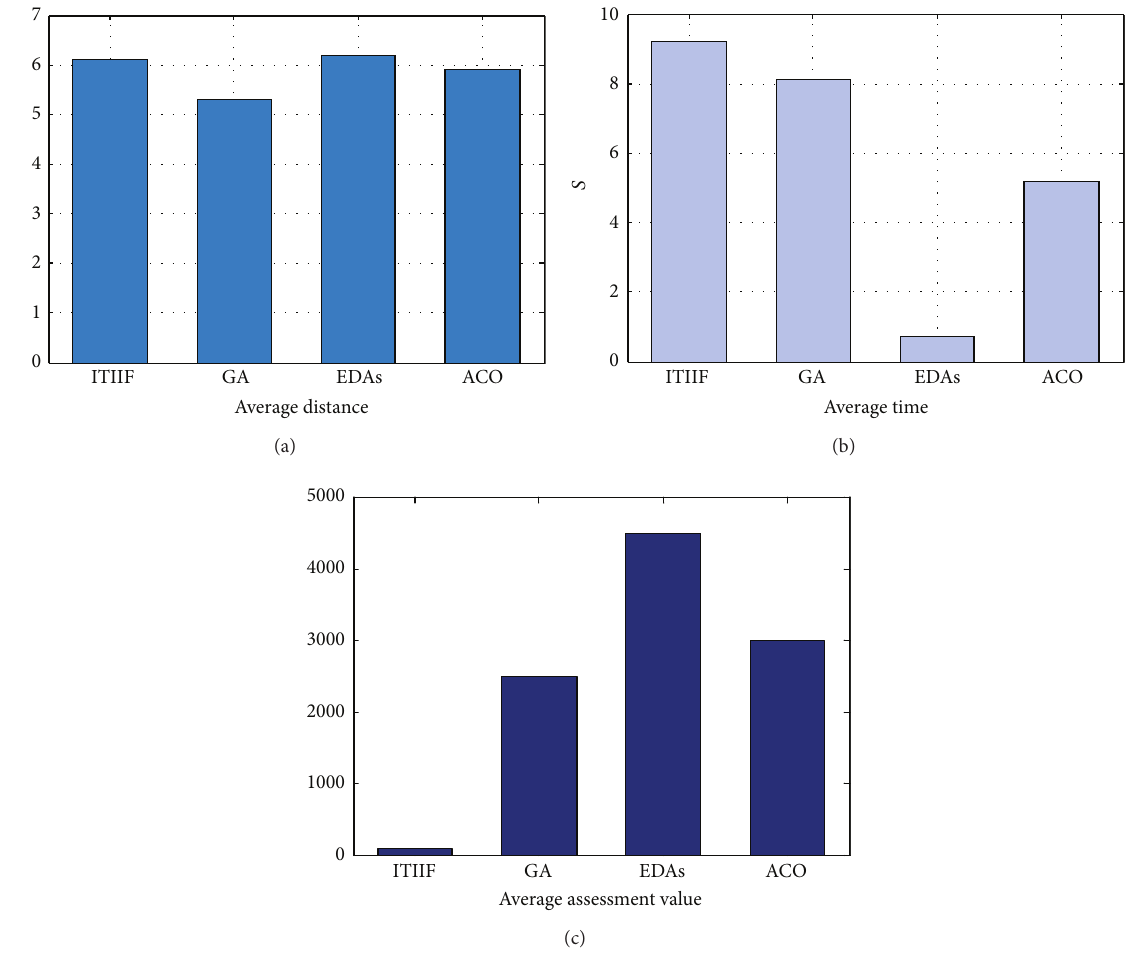
Figure 7: The performance comparison of ITIIF, GA, EDAs, and ACO. Table 2: The solution results of the testing functions by ITIIF algorithm, binary particle swarm algorithm, and binary differential evolution algorithm. Binary particle swarm algorithm Binary differential evolution algorithm ITIIF algorithm proposed in this Function